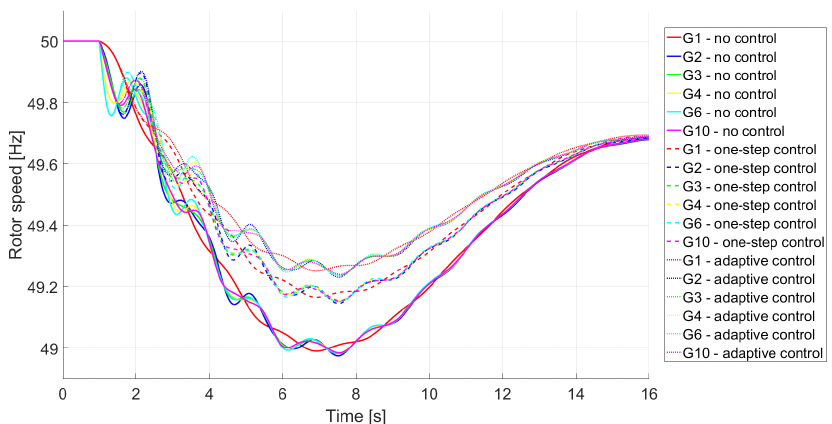
Figure 17. Generators’ rotor speed in Configuration II in case of small disturbance.